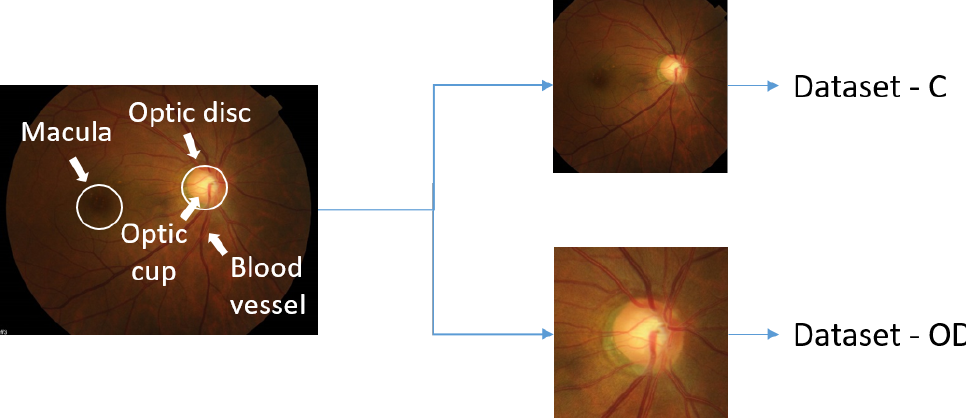
Figure 2. Taking into account the clinical importance of the Optic Disc (OD) and the macula, the original dataset was used to created two additional datasets, either by center-cropping the original images (Dataset-C) or by extracting the optic disc from the original images